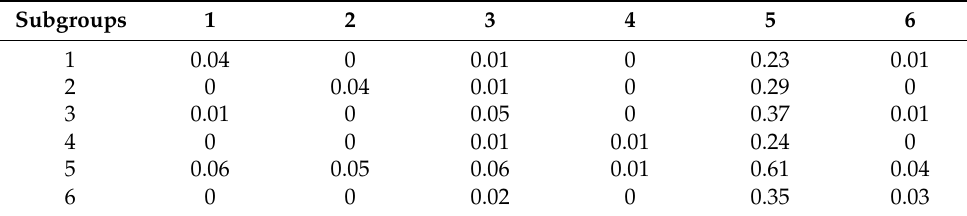
Figure 7. Cohesive subgroups of the tourism information flows in China. Table 1. Distribution of the cohesive subgroup